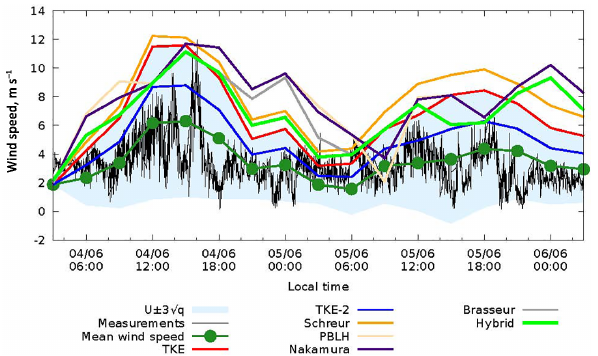
Figure 2. Time series for 4–6 June 2016 of measured wind speed with 3s averaging and one forecast starting at 03:00LT on 4 June of wind speed and gusts by seven methods described in Sect. 2.